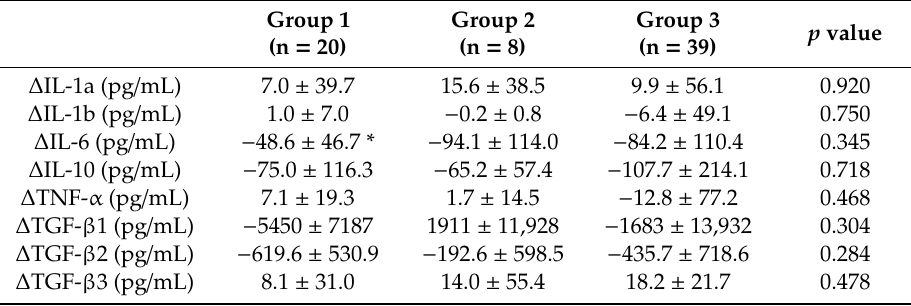
Table 5. Comparison changes of cytokine level among groups.